Question: Looking at the figure, what chart type is it?
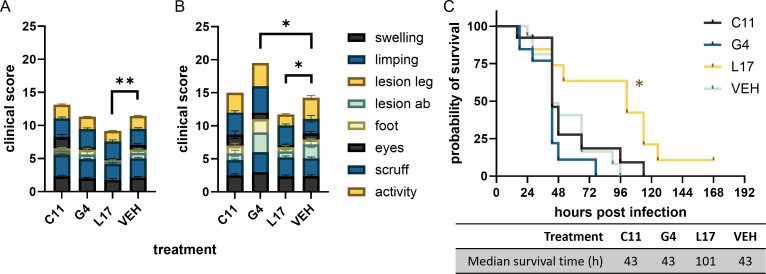
Answer: survival